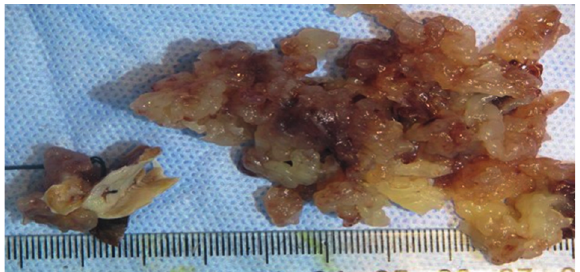
Figure 2: A macroscopic picture of the specimen showing the bulk of the tumor consisting of friable gelatinous tan tissue fragments with a papillary surface (on the right) along with the site of attachment (atrial septal myocardium on the